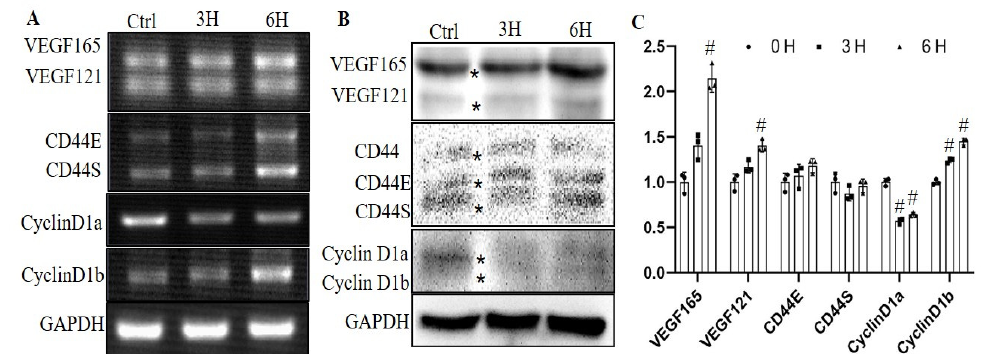
Figure 2. The effects of mechanical strain on the alternative splicing of VEGF, CD44 and cyclin D1. Reverse transcription semi-quantitative PCR ( A ) and Western blotting ( B ) were applied to examine the alternative splicing of VEGF , CD44 and cyclin D1 at 3 and 6 h after mechanical strain. C. The expressions of gene variants shown in B were quantified by Image J software. Data present three sets of independent experiments. #: p < 0.05 vs. the 0 h group. The stars * indicate the bands of gene variants.